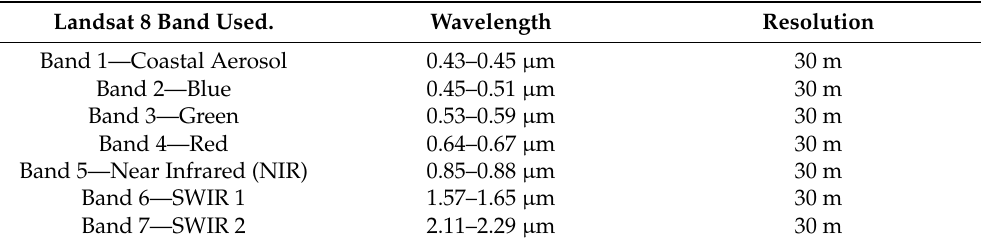
Table 3. Information about the bands that were added to the new project. Landsat 8 Band